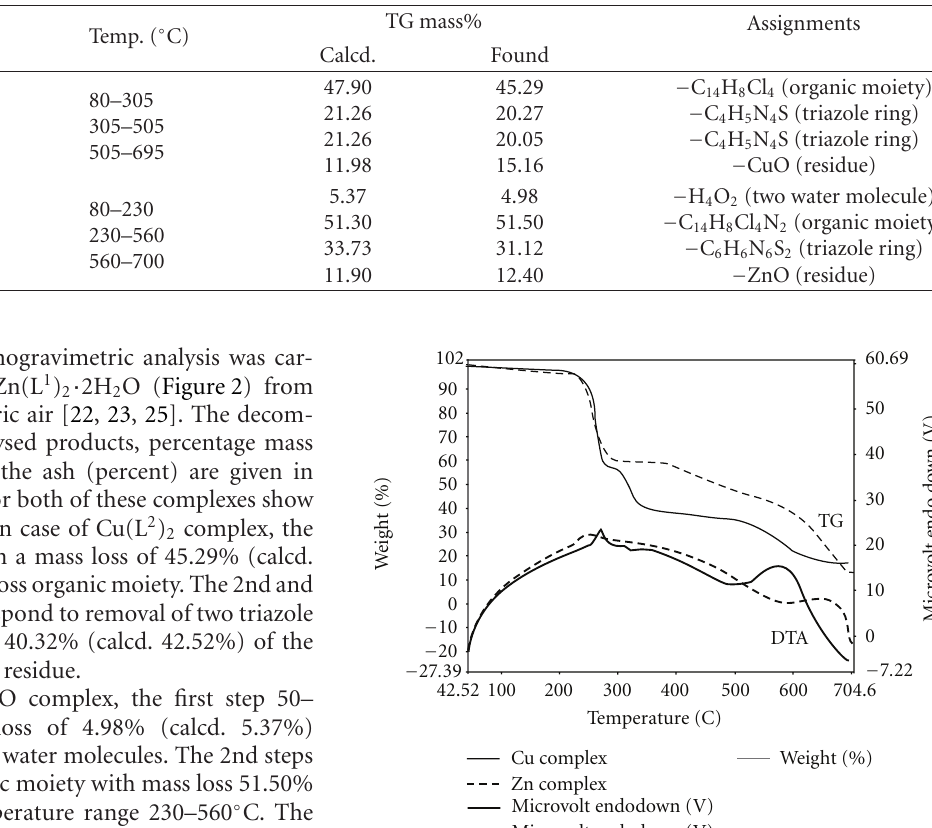
inhibitory e ff ect against any of the test organism as shown in Tables 5, 6, and